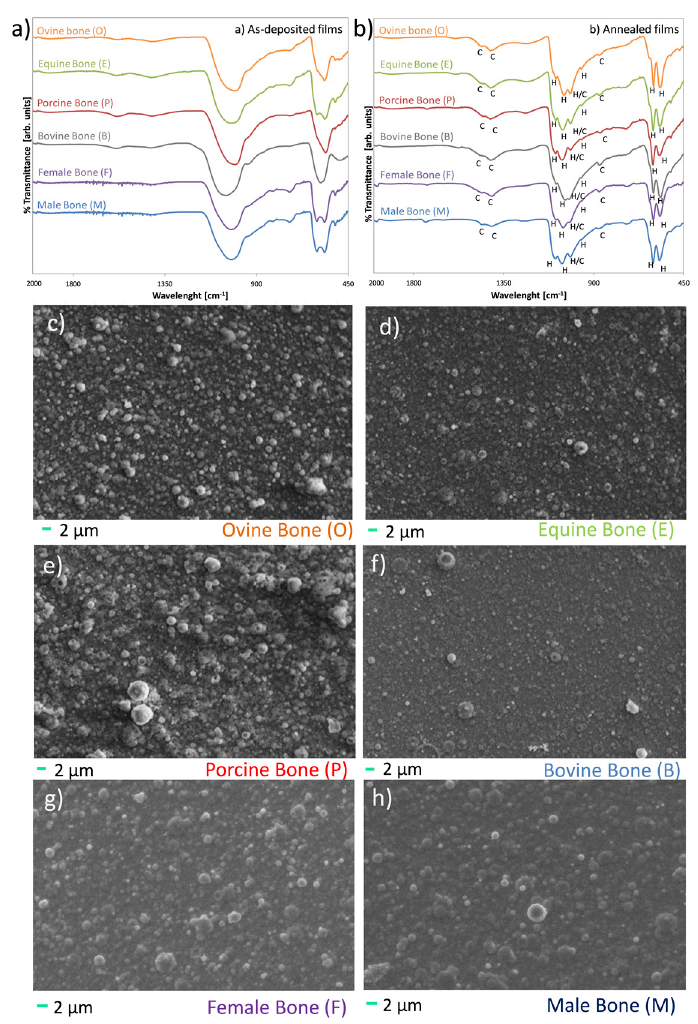
Figure6. Compositionofthecoatingsbefore( a )andafter( b )thermaltreatment. ( c – h )Morphologyofthe coatings deposited from di ff erent sources. All as-deposited coatings are amorphous, as